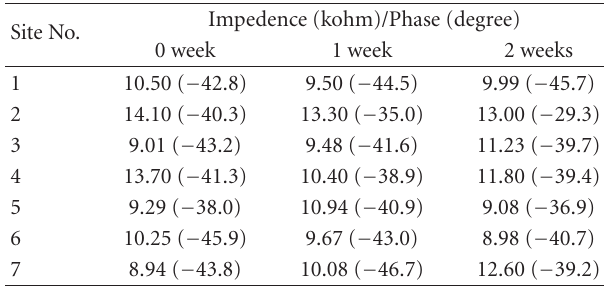
Table 1: Measured impedance at 1KHz in vivo for two weeks af- ter implantation. The strip-shaped seven-segment electrode array was placed into the suprachoroidal space and reference electrode was placed on the surface of sclera. A strip-shaped electrode site was connected to the working electrode input, and the stimulating reference electrode served as the counter and reference electrode. 0 week means the day of implantation. Site No.